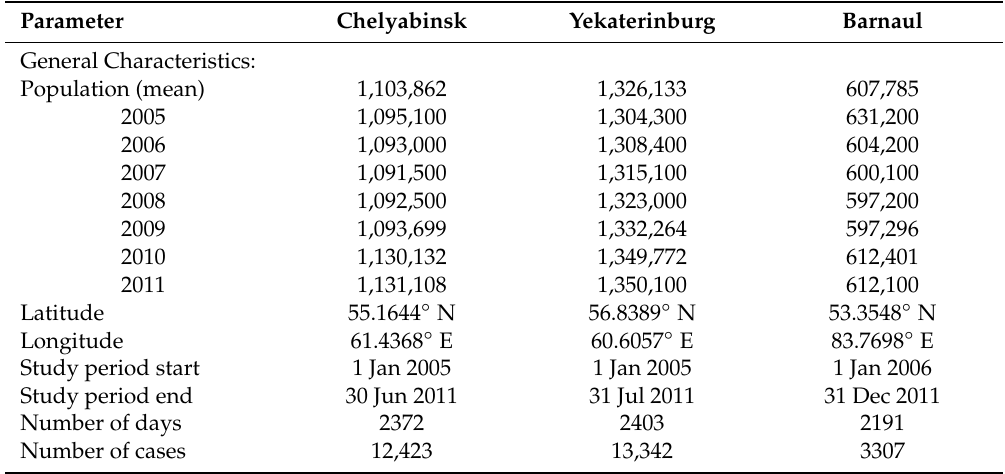
Table 1. General study site characteristics: population, location, study period, and total number of rotavirus cases for three Russian cities: Chelyabinsk, Yekaterinburg and Barnaul,